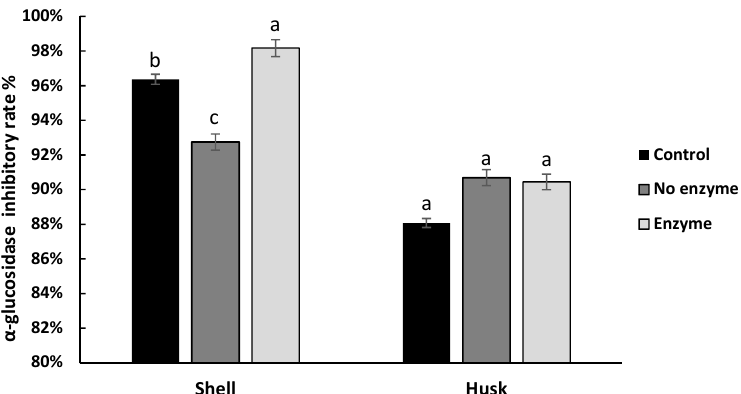
Figure 5. The inhibitory rate of walnut pigment from brown shell and green husk on α -glucosidase activity with / without enzyme digestion. The data presented in this table consist of average quantities ± SD of three independent samples. Di ff erent letters (a–c) in the bars within each group represent statistically signi fi cant di ff erences ( p < 0.05).